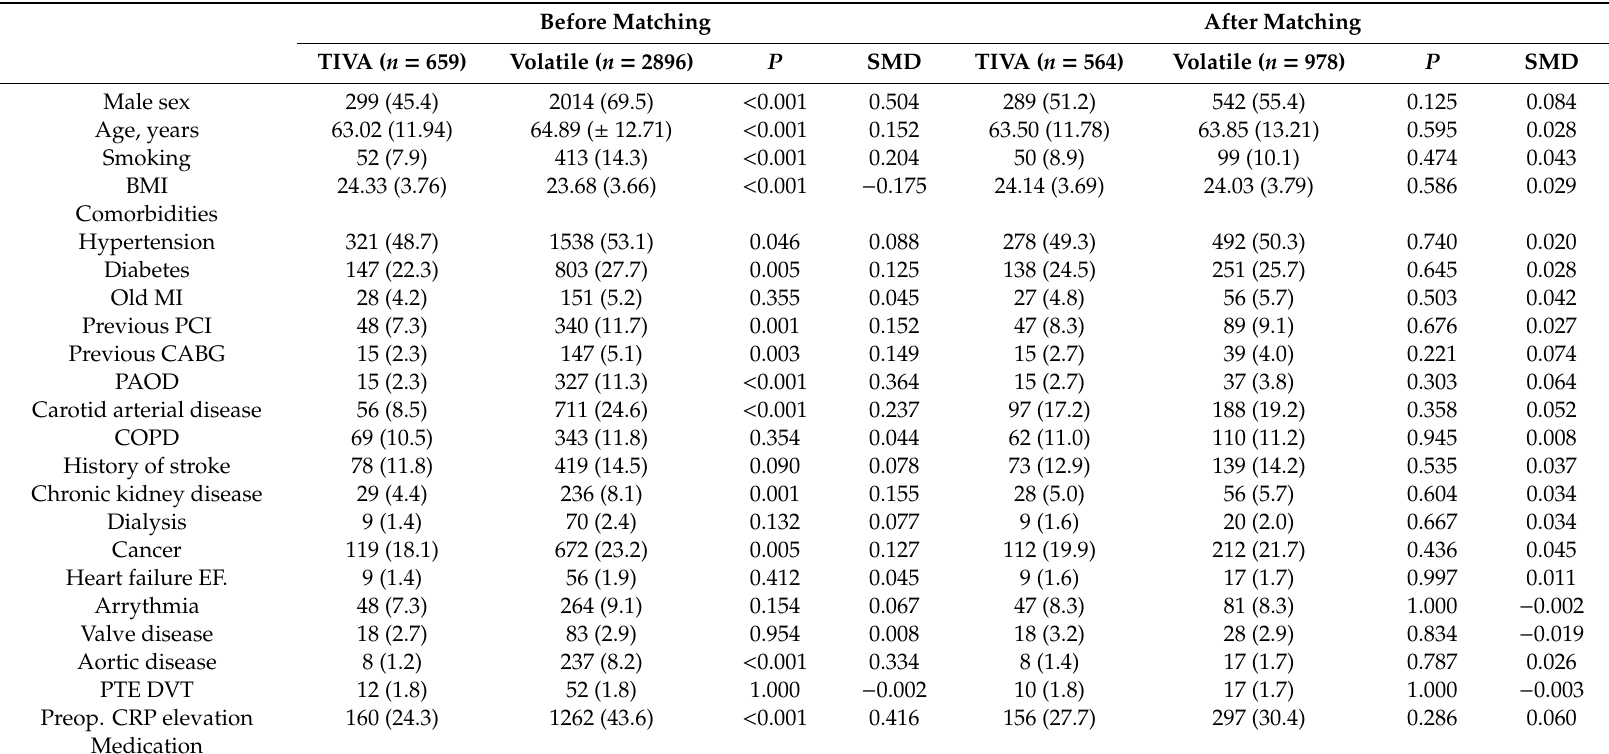
Table 1. Balance in clinical characteristics between the TIVA and volatile groups, before and after